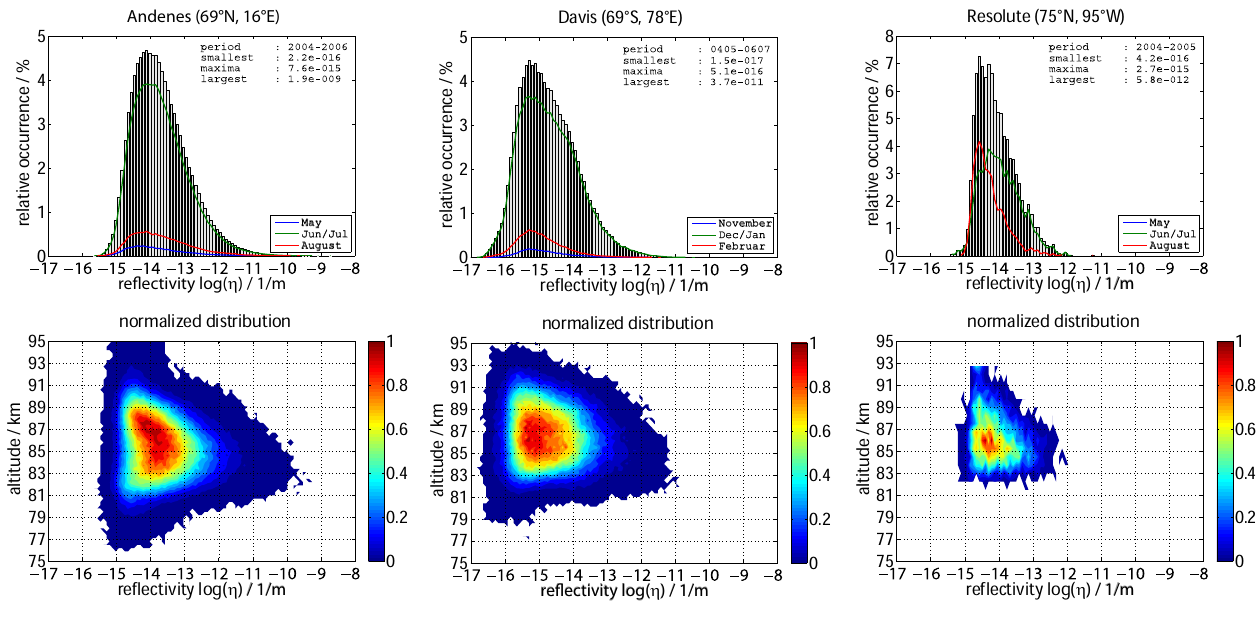
Fig. 7. Relative occurrence of reflectivity and their normalized distribution vs. altitude after PMSE observation at Andenes (2004–2006, left), Davis (0405–0607, middle) and Resolute Bay (2004–2005, right).